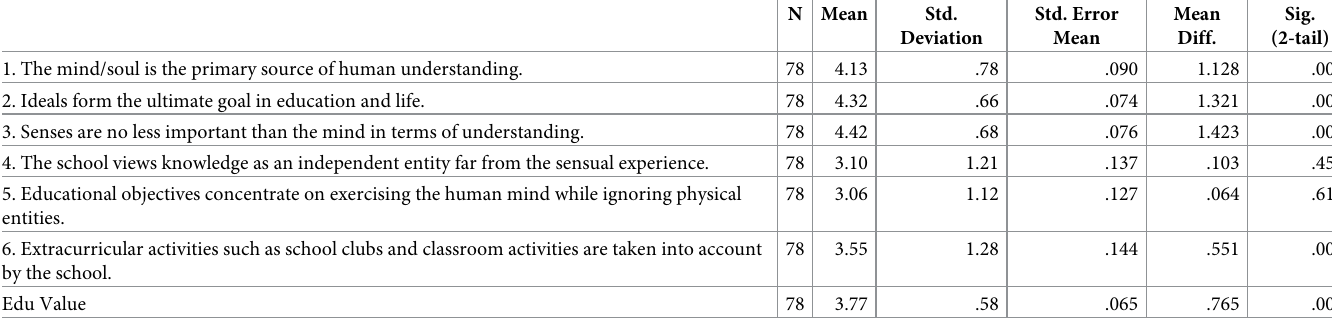
Table 5. One-sample statistics (educational values and related items, test value =